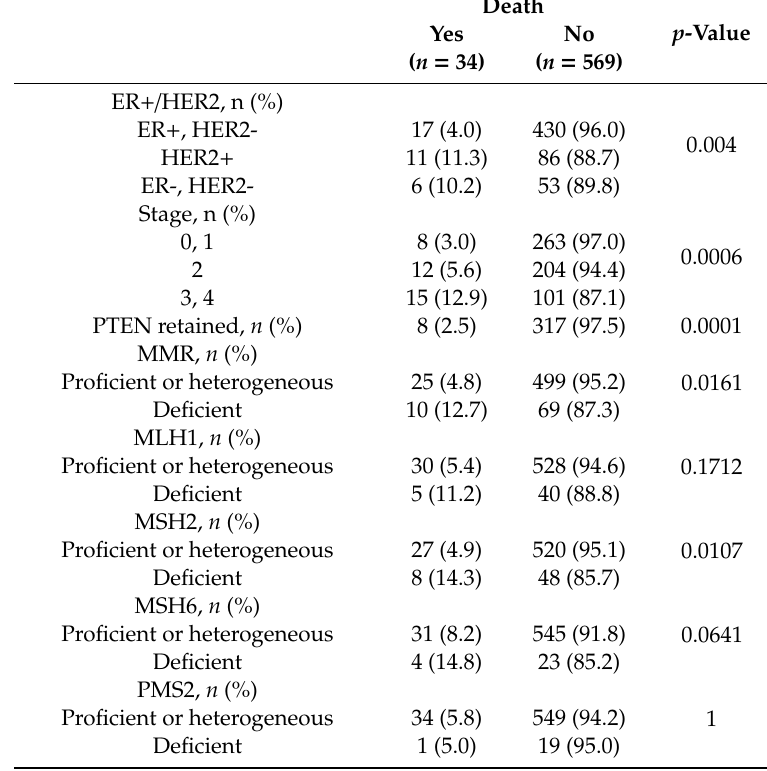
Table 2. Bivariate analysis showing the association of selected clinicopathologic characteristics with patients’ death. ER, estrogen receptor; MMR, mismatch repair; MLH1, mutL homologue 1; MSH2, mutS homologue 2; MSH6, mutS homologue 6; PMS2, postmeiotic segregation increased 2 (PMS2).